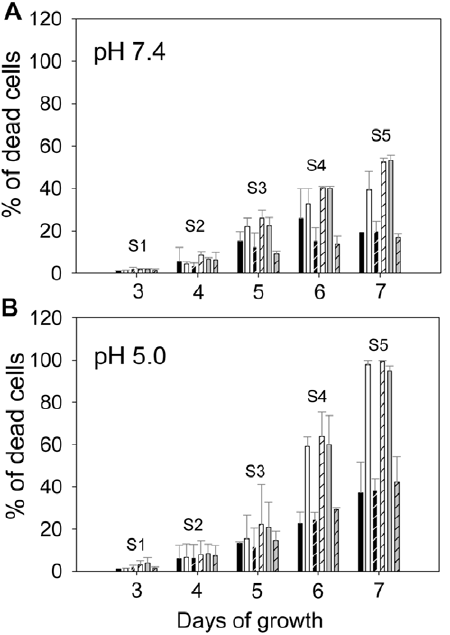
Figure 5. The IPCase activity was required for acid resistance in stationary phase promastigotes. Promastigotes were cultured under either neutral pH (pH 7.4, A ) or acidic pH (pH 5.0, B ). Cell viability in stationary phase (S1–S5) was determined by flow cytometry after staining with propidium iodide. Each group of bars represents cells in the following order (from left to right): WT, iscl 2 , iscl 2 / + HA-ISCL, iscl 2 / + HA-BcSMase, iscl 2 / + 5 9 HASPb-BcSMase-HA, and iscl 2 / + CnISC1. Error bars represent standard deviations from 3 independent exper- iments.